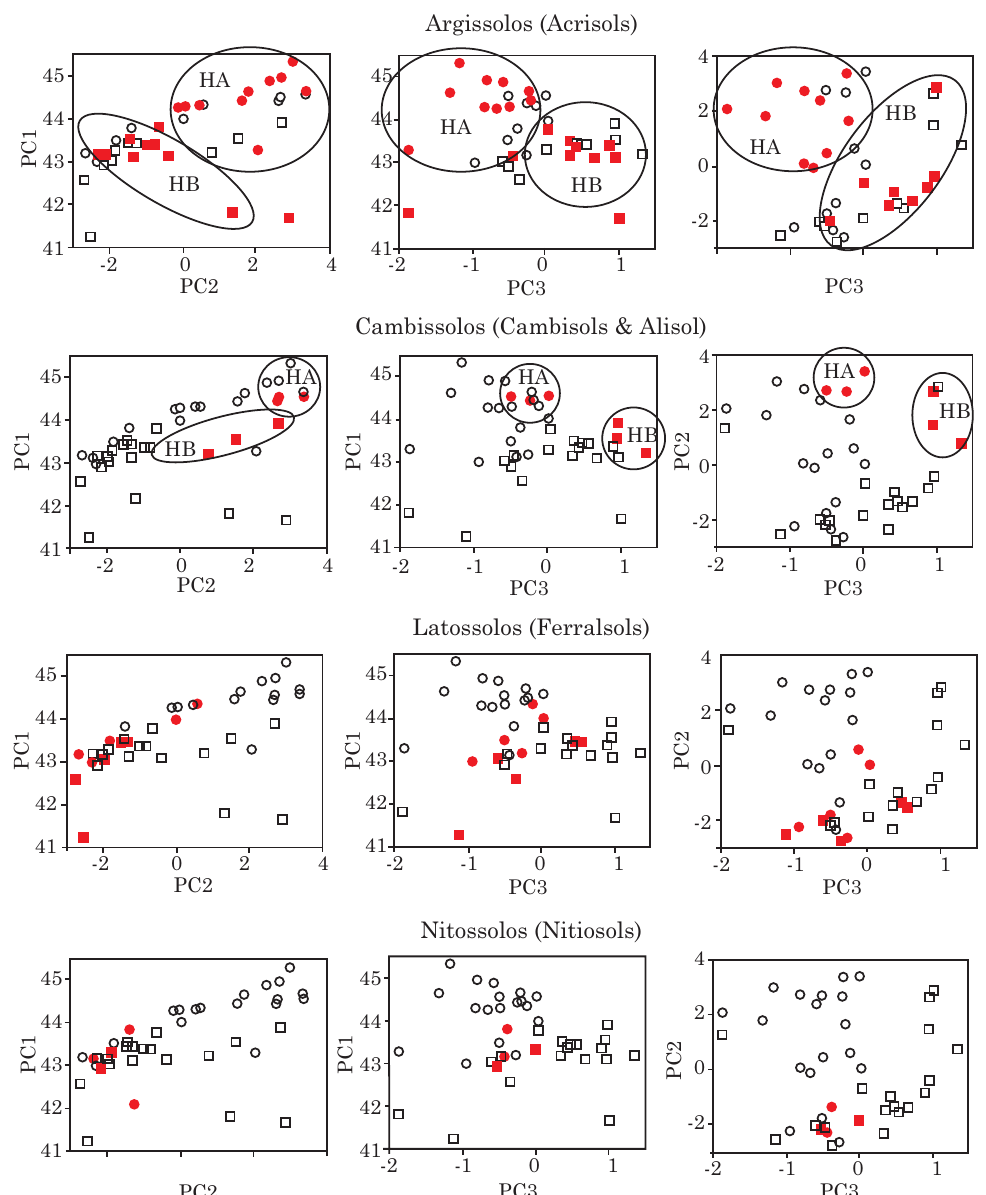
Figure 4. Graphs representing the principal components 1, 2 and 3 of the spectra from the profiles of Argissolos, Cambissolos, Latossolos and Nitossolos in the surface ( lllll ) and subsurface ( nnnnn )